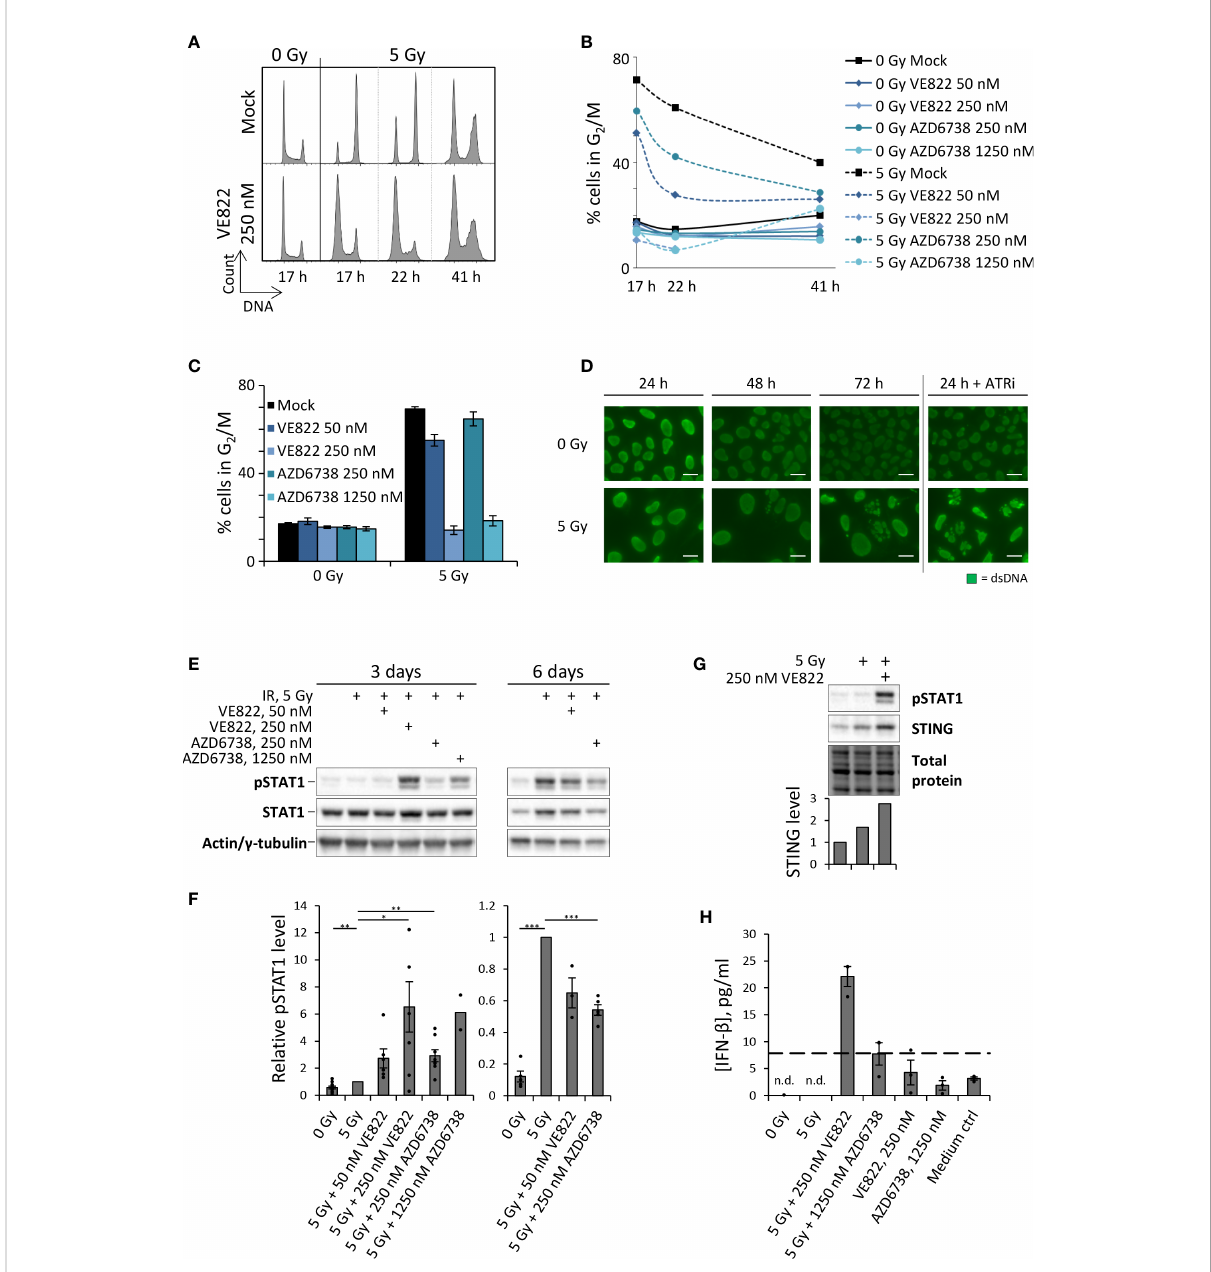
FIGURE 2 ATRi abrogates radiation-induced G2 checkpoint arrest, resulting in expedited generation of micronuclei and induction of type I IFN response in U2OS cells. (A) DNA histograms after treatment with IR and VE822. (B) Quanti fi cation of proportion of cells in G2/M phase from the experiment in (A) . (C) Bar-plotted quanti fi cation of G2/M proportions from three independent experiments performed as in (A) , at 17 hours after treatments. (D) Micrographs showing anti-dsDNA immuno fl uorescence staining. ATRi: 250 nM VE822. Scale bars: 20 µm. (E) Immunoblot of phosphorylated STAT1 (pSTAT1) and total STAT1 (STAT1) three and six days after IR with or without VE822 and AZD6738. Pan-actin and g -tubulin were used as loading controls at three and six days, respectively. (F) Quanti fi cation of pSTAT1 levels relative to loading controls for experiments as in (E) . Values are normalized to 5 Gy. (G) Immunoblot of pSTAT1 and STING in U2OS cells at three days after the indicated treatments. Bar chart shows STING level relative to total protein and normalized to mock. (H) ELISA of IFN- b in 20X up-concentrated growth media from U2OS cells harvested three days after treatment. Dashed line indicates the lowest interferon- b concentration tested in the standard curve in Supplementary Figure S1E (7.81 pg/ml). n.d. = not